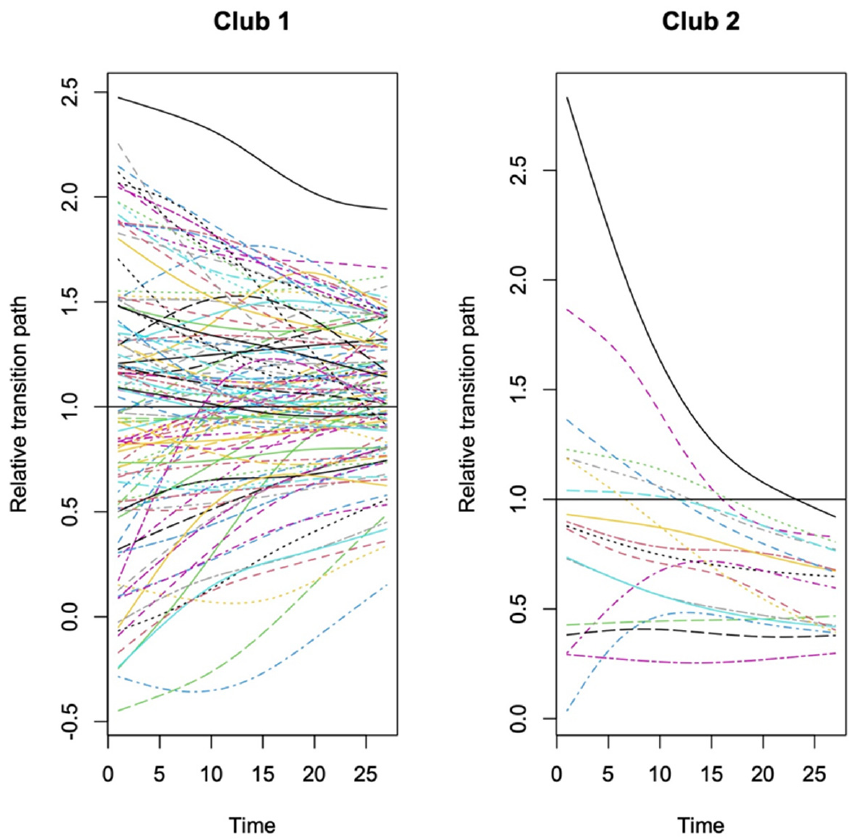
Figure 1. Relative transition path (clubs 1 and 2). Source: authors’